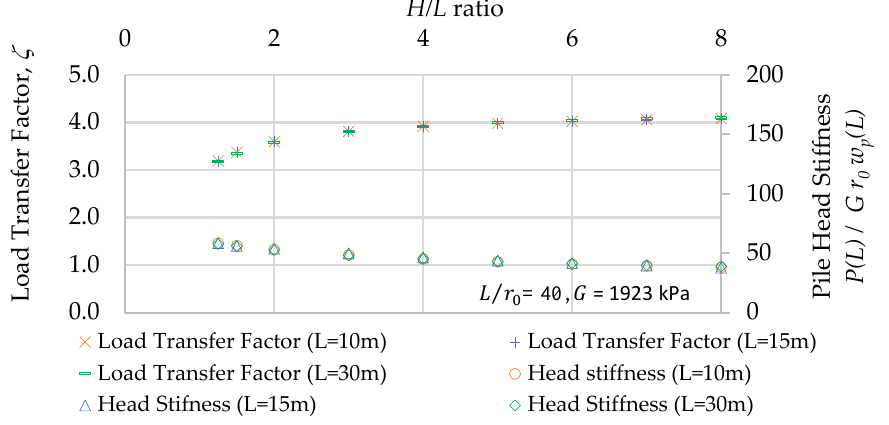
Figure 2. Load transfer factor and pile head stiffness, versus 𝐻/𝐿 ratio. After determining the optimum mesh and boundary geometries, the FE model used in